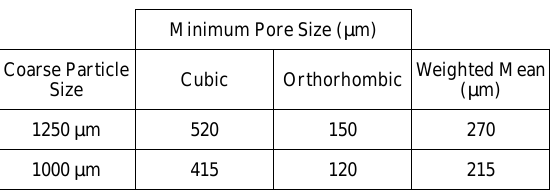
Table 3 Minimum pore sizes for cubic and orthorhombic arrange- ments